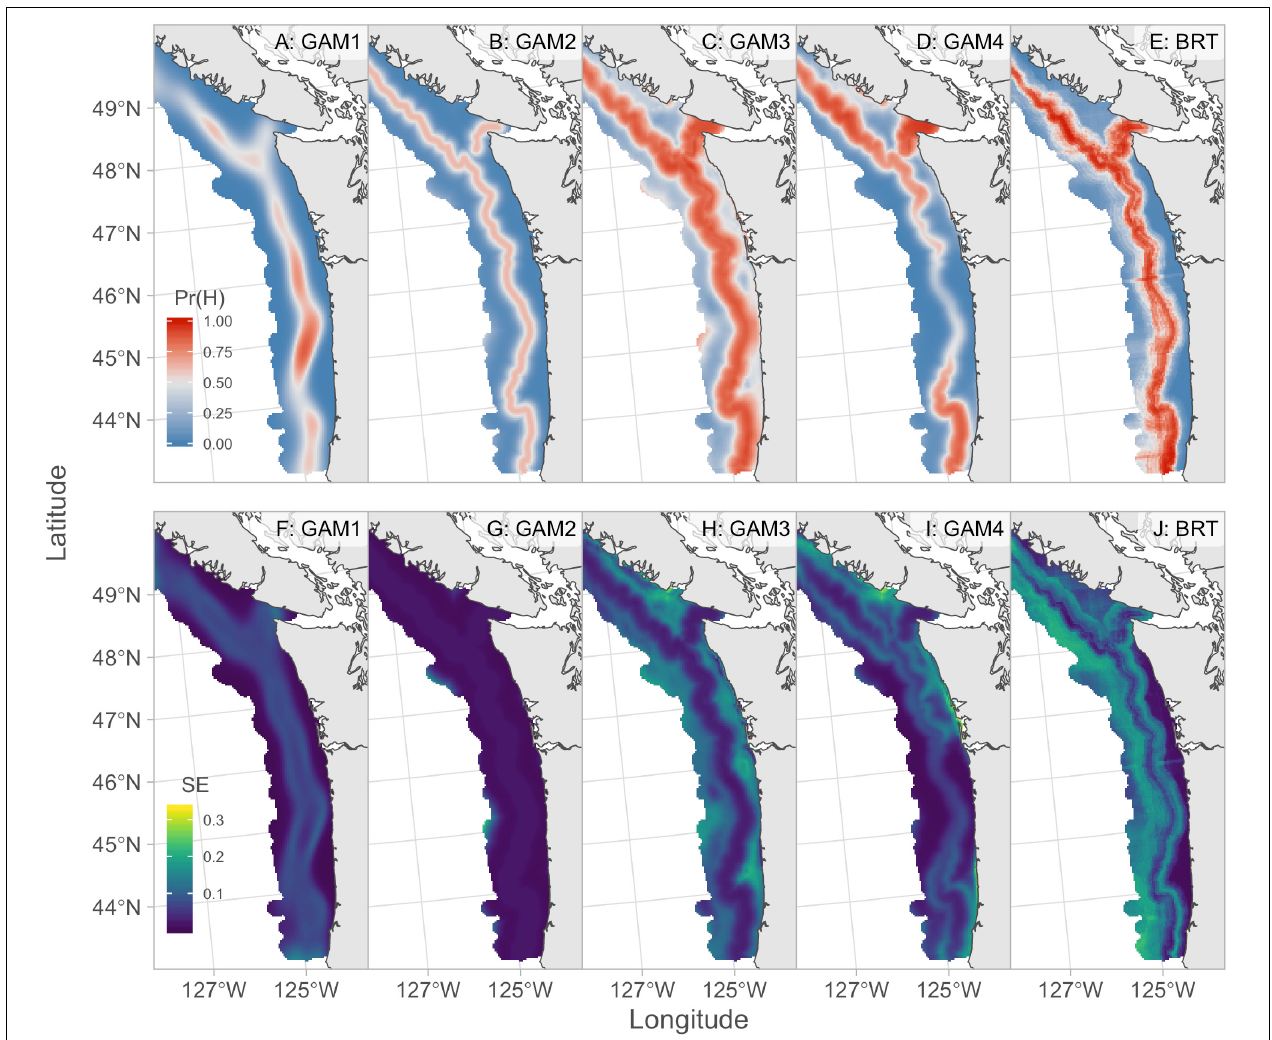
FIGURE 6 | August 2019 forecasts of hake occurrence from individual forecast models. Top row (A–E) shows the probability of hake occurrence where red indicates probabilities greater than 0.5 and blue indicates probabilities less than 0.5. Bottom row (F–J) shows the associated standard errors for each model where brighter colors indicate higher forecast